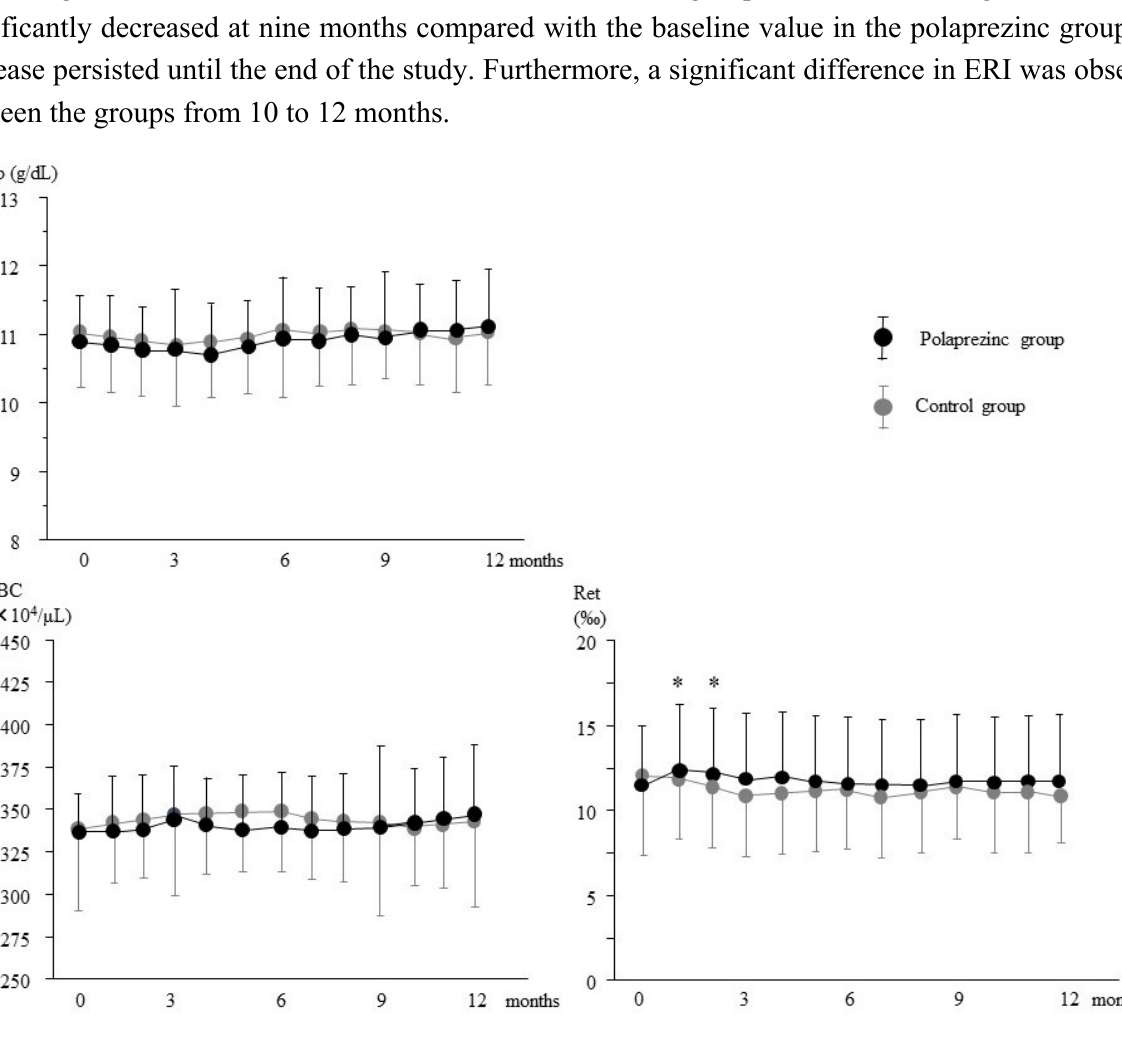
Figure 1. Changes in hemoglobin, red blood cell count, and reticulocyte levels during the study period. Hb, hemoglobin; RBC, red blood cell; Ret, reticulocyte. Data are expressed as mean ± SD, * p < 0.05 vs.